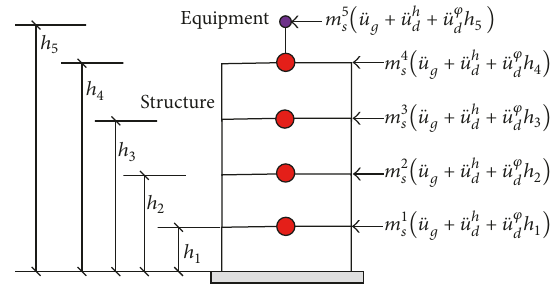
Figure 2: Equivalent load